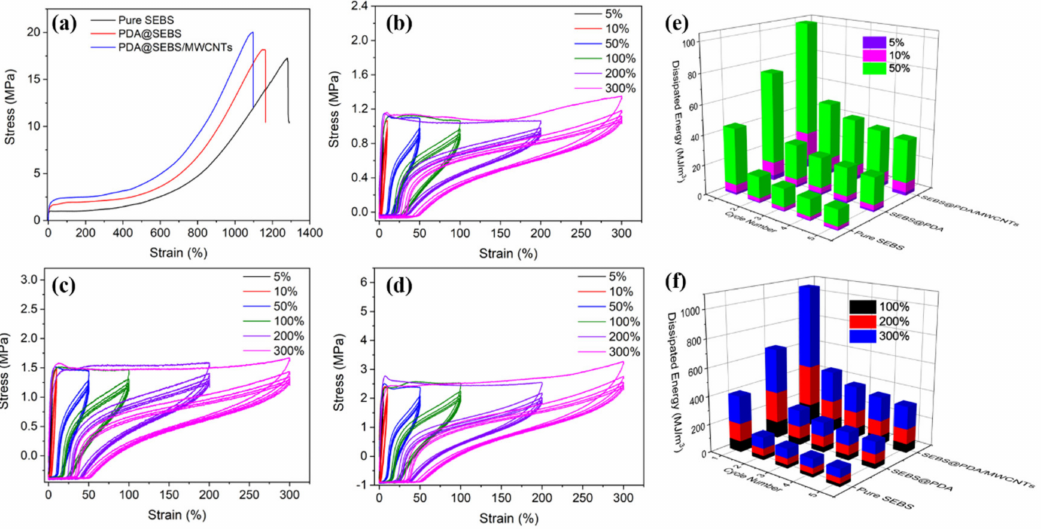
Figure 6. ( a ) Stress vs. strain curves of SEBS, PDA@SEBS, and PDA@SEBS/MWCNTs yarns at a feed rate of 100 mm/min. Stress vs. strain curves of the initial five tensile cycles for ( b ) SEBS yarn,